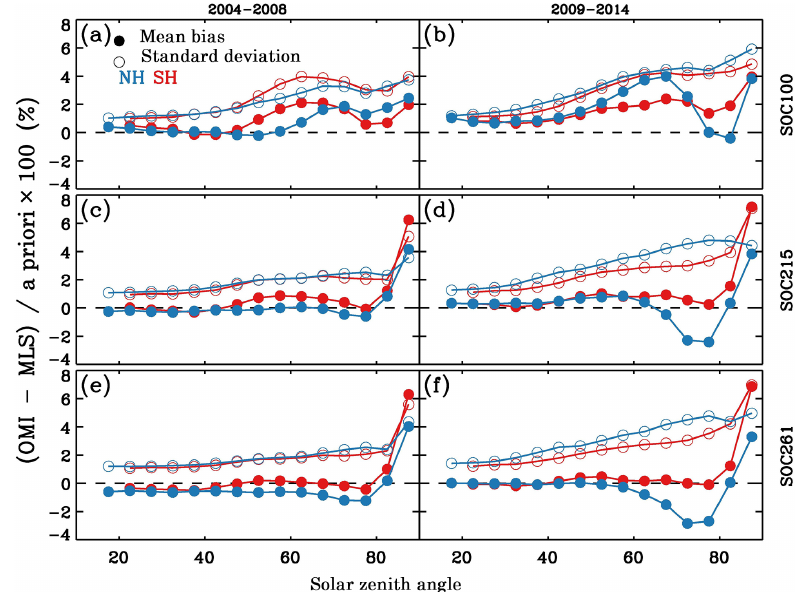
Figure 9. Mean biases (solid circles) and standard deviations (open circles) of the differences between OMI and MLS stratospheric ozone columns (SOCs) above 100hPa (a, b) , 215hPa (c, d) , and 261hPa (e, f) as a function of solar zenith angle for Northern Hemisphere (blue) and Southern Hemisphere (red) during 2004–2008 (left) and 2009–2014 (right). Please noted that standard deviations are plotted with the zero line as reference.